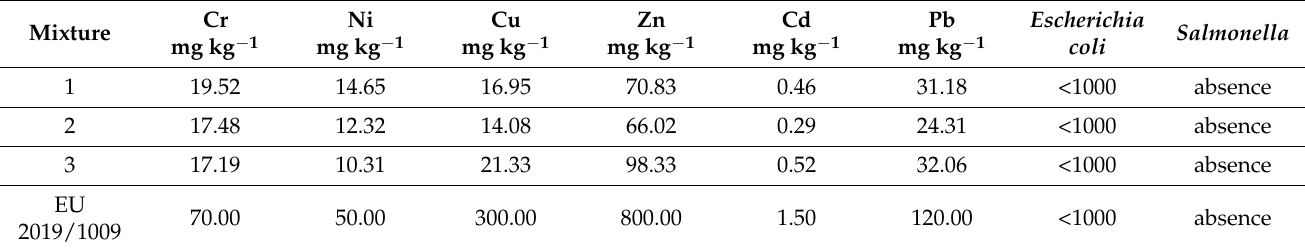
Table 4. Metal and microorganism content values at the end of the test and limits. Table 5. Nutrient values at the end of the test. Table 5. Nutrient values at the end of the test.